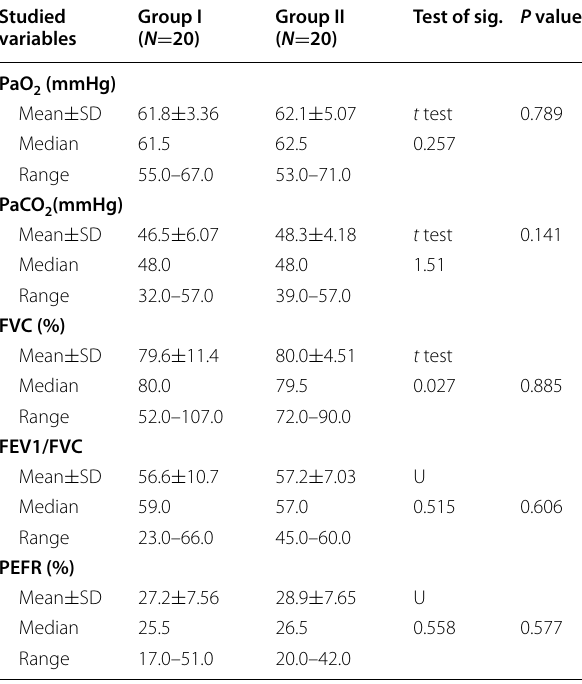
Table 3 Comparison between the studied groups regarding diaphragm finding by ultrasound ( N